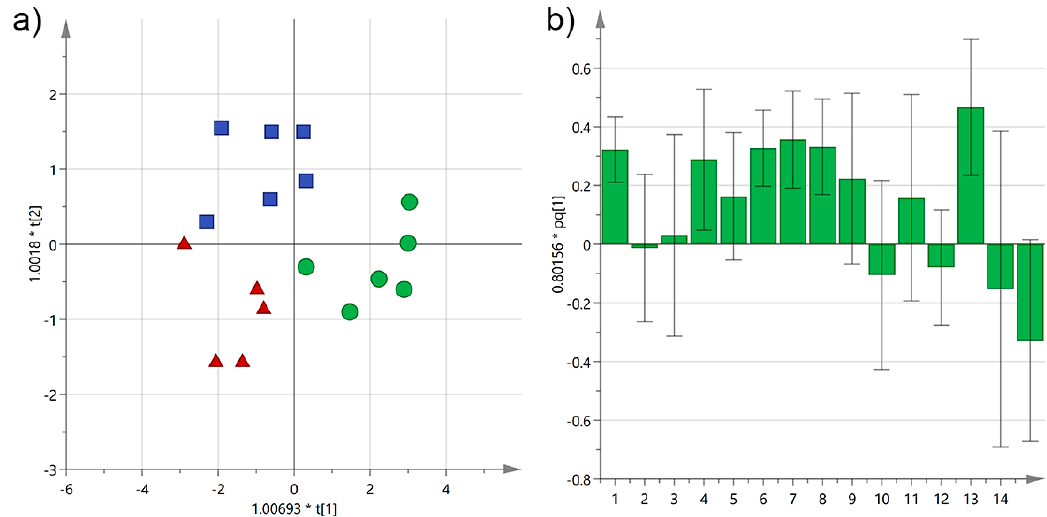
Figure 11. ( a ) OPLS-DA score plot for Cellina EVOO samples from Salento categorized by their proximity either to the Adriatic (green circles) or Ionian Sea (red triangles), or to neither of them (blue squares); ( b ) OPLS-DA loadings column plot for the first predictive component of the model (variables: 1 = total biophenols; 2 = hydroxytyrosol; 3 = tyrosol; 4 = 3,4-DHPEA-EDA; 5 = 3,4-DHPEA-EA; 6 = lignans; 7 = luteolin; 8 = p -HPEA-EDA; 9 = p -HPEA-EA; 10 = 3,4-DHPEA-EA in the mixed aldehydic and hydroxylic form; 11 = p -HPEA-EA in the mixed aldehydic and hydroxylic form; 12 = α -tocopherol; 13 = Adriatic area; 14 = central mainland; 15 = Ionian